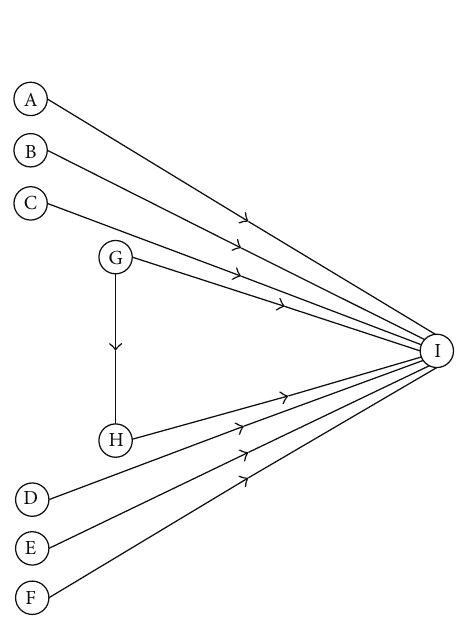
Figure 7: Transportation task III.